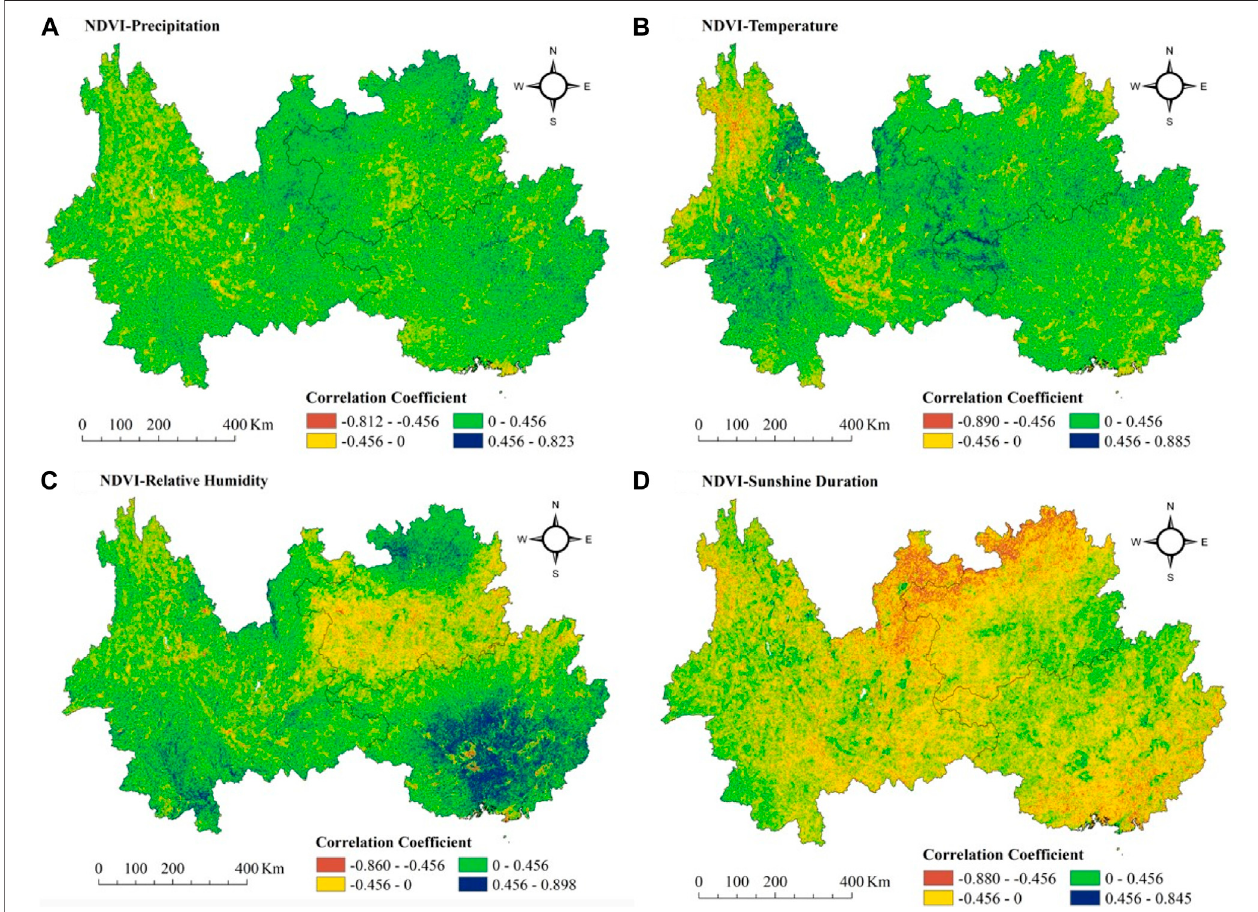
FIGURE 9 | The correlation among NDVI and climate factors in the three karst provinces of southwest China.